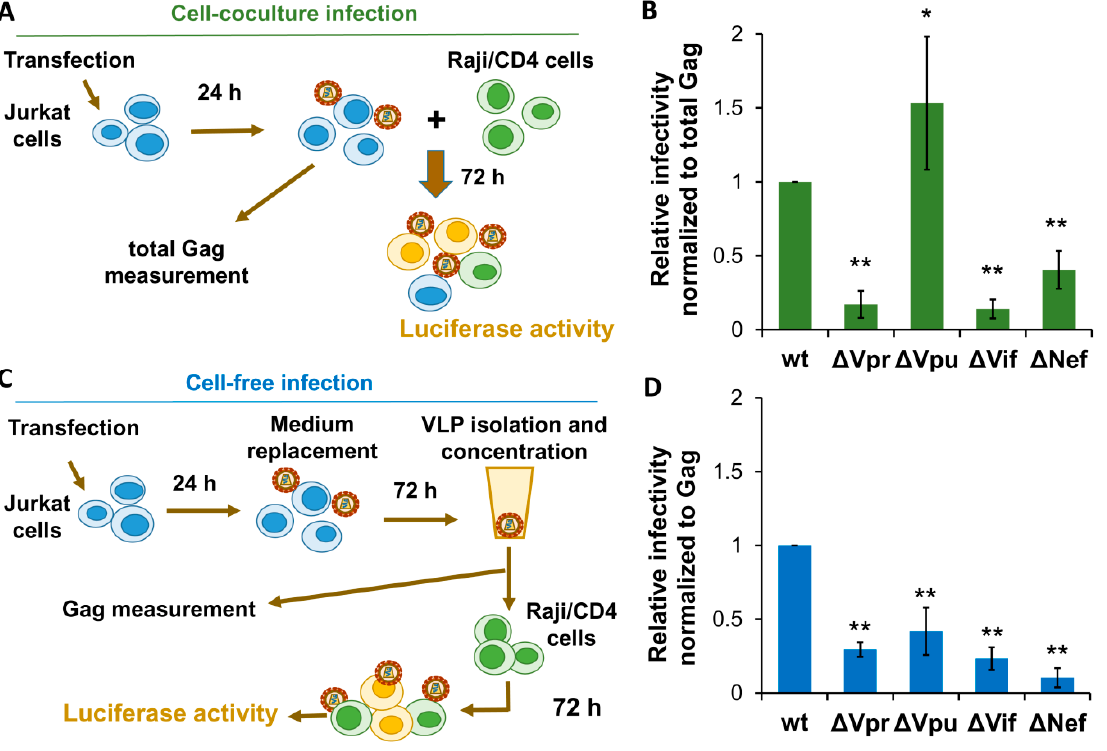
Figure 3. The requirements for HIV-1 accessory proteins during HIV-1 replication in lymphoid cells. ( A ) Schematic experimental design for evaluation HIV-1 replication in Jurkat-Raji / CD4 cell cocultures. ( B ) The results of HIV-1 relative infectivities measured in Jurkat-to-Raji / CD4 cell cocultures. ( C ) Scheme of experimental set up for detecting infectivity of HIV-1 VLPs derived from Jurkat cells and applied to Raji / CD4 target cells. ( D ) The levels of infectivity of VLPs purified from Jurkat cells and use to infect Raji / CD4 cells. The levels of replication were calculated as described for Figure 2 and as specified in the Results section. The data shown as average values ± standard deviations are representative of at least three independent experimental repeats. *, **, statistically di ff erent from the control (wt) at p < 0.05 and p < 0.01,